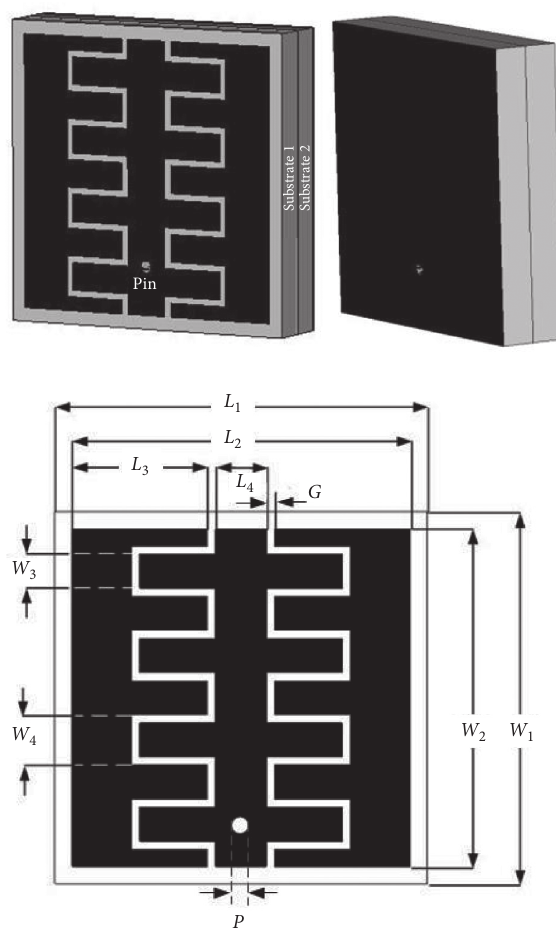
Figure 4: The geometry of ICPW-EBG unit cell. Table 1: ICPW-EBG unit cell parameter and